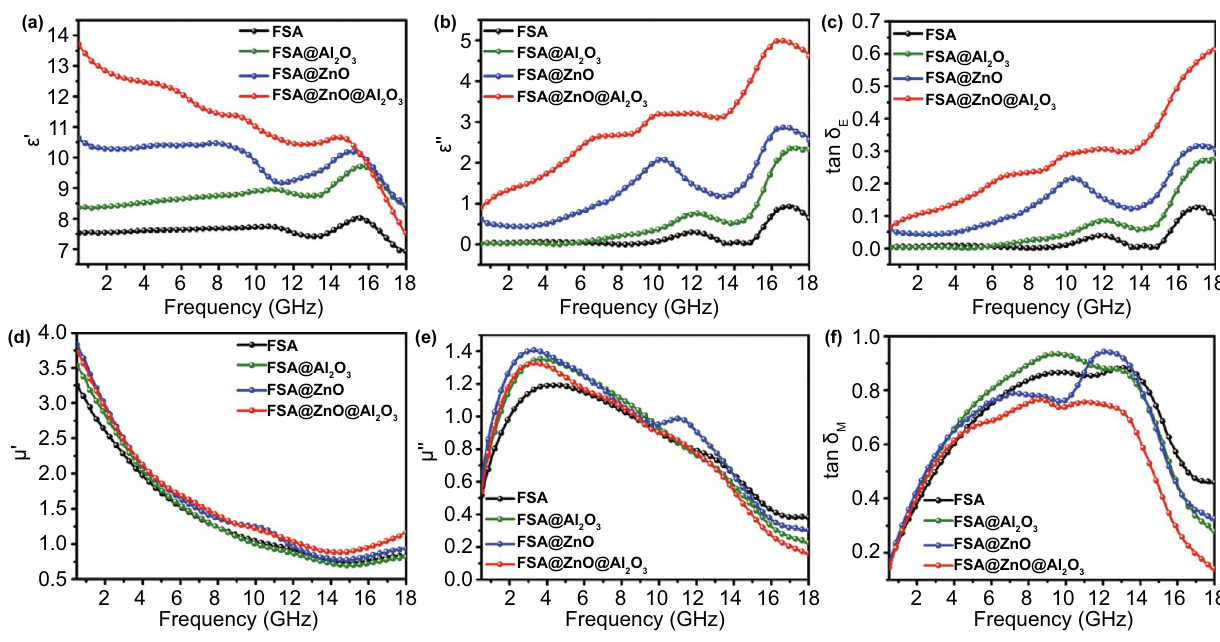
Fig. 3 The frequency dependence of electromagnetic parameters of FSA alloy, FSA@Al 2 O 3 , FSA@ZnO, and FSA@ZnO@Al 2 O 3 : a real parts (ε ′ ), b imaginary parts (ε ′′ ), c dielectric loss tangents of the complex permittivity, d real parts (μ ′ ), e imaginary parts (μ ′′ ) and f magnetic loss tangents of the complex